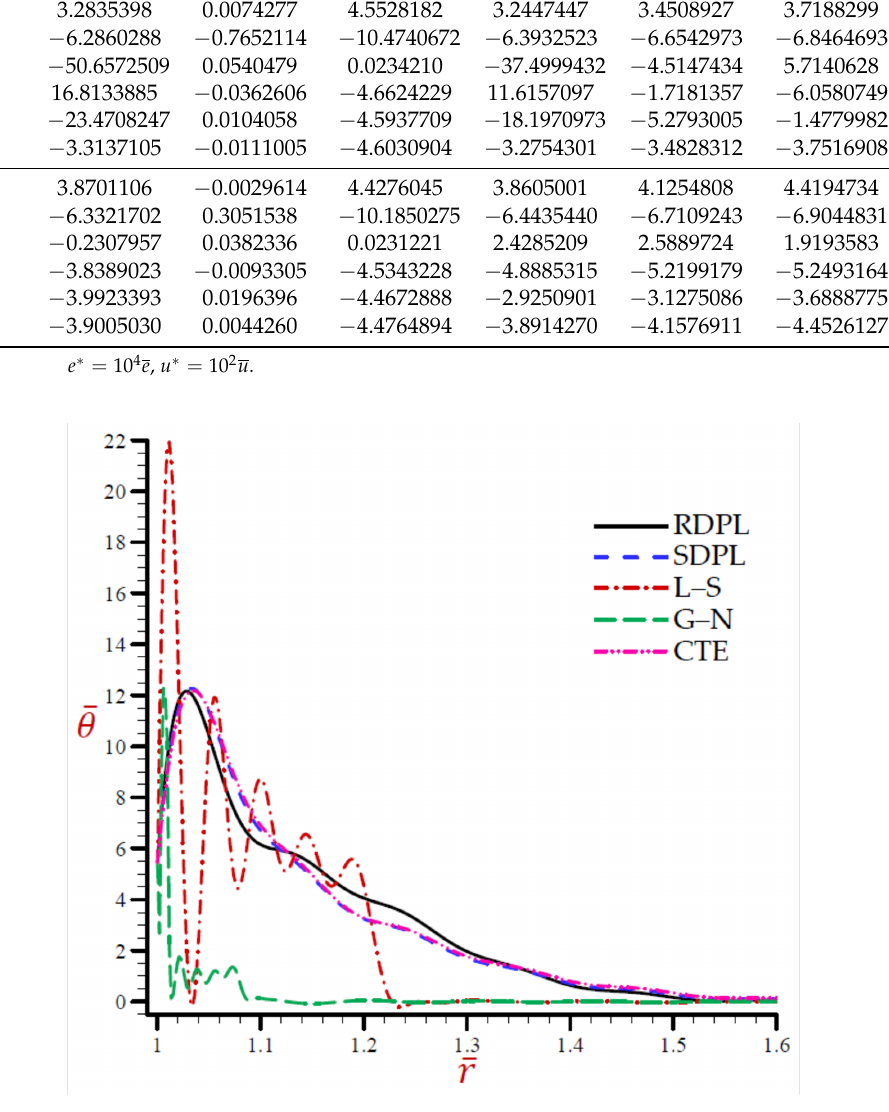
Figure 1. The temperature θ across the radial direction of the cylindrical cavity conferring to all